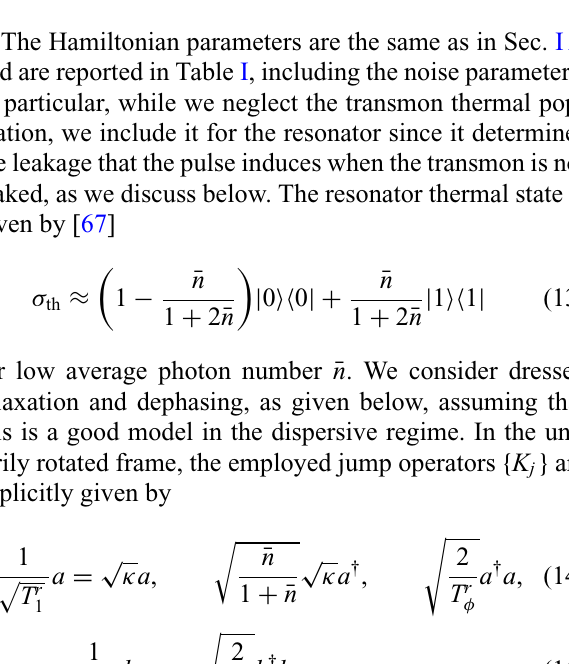
FIG. 2. Lindblad simulations of the transmon-resonator sys- tem for the readout-resonator LRU. In (a),(b) the initial state is | 0 (cid:2)(cid:10) 0 | ⊗ σ σ | 2 (cid:2)(cid:10) 2 | ⊗ σ th , while in (c),(d) it is th , where th is the res- onator thermal state. (a),(c) Transmon leakage population p | 2 (cid:2) = ρ( T ) ] | 2 (cid:2) at the end of the time slot of T = 440 ns. (cid:10) 2 | Tr slot slot r [ For each choice of ((cid:6) , ω d ) , we optimize the total pulse duration t p ≤ T slot to minimize p | 2 (cid:2) given the initial state | 2 (cid:2)(cid:10) 2 | ⊗ σ th for fixed t rise = 30 ns. The white star indicates the chosen operating point ( (cid:6)/ 2 π ≈ 204 MHz, ω d / 2 π ≈ 5.2464 GHz, t p = 178.6 ns) with p | 2 (cid:2) op. ≈ 0.5% in (a). The induced leakage in (c) is p | 2 (cid:2) ≈ 0.48% at the operating point. The purple line corresponds to as the higher-order estimate of the optimal drive frequency ω ∗ d a function of (cid:6) [see Fig. 1(c)]. The heatmaps are sampled using the ADAPTIVE package [66]. (b),(d) Time evolution of the pop- ulations in a few selected states for the operating point. The vertical dashed line indicates the used t p . The inset in (d) shows a schematic of the pulse (cid:6)( t )